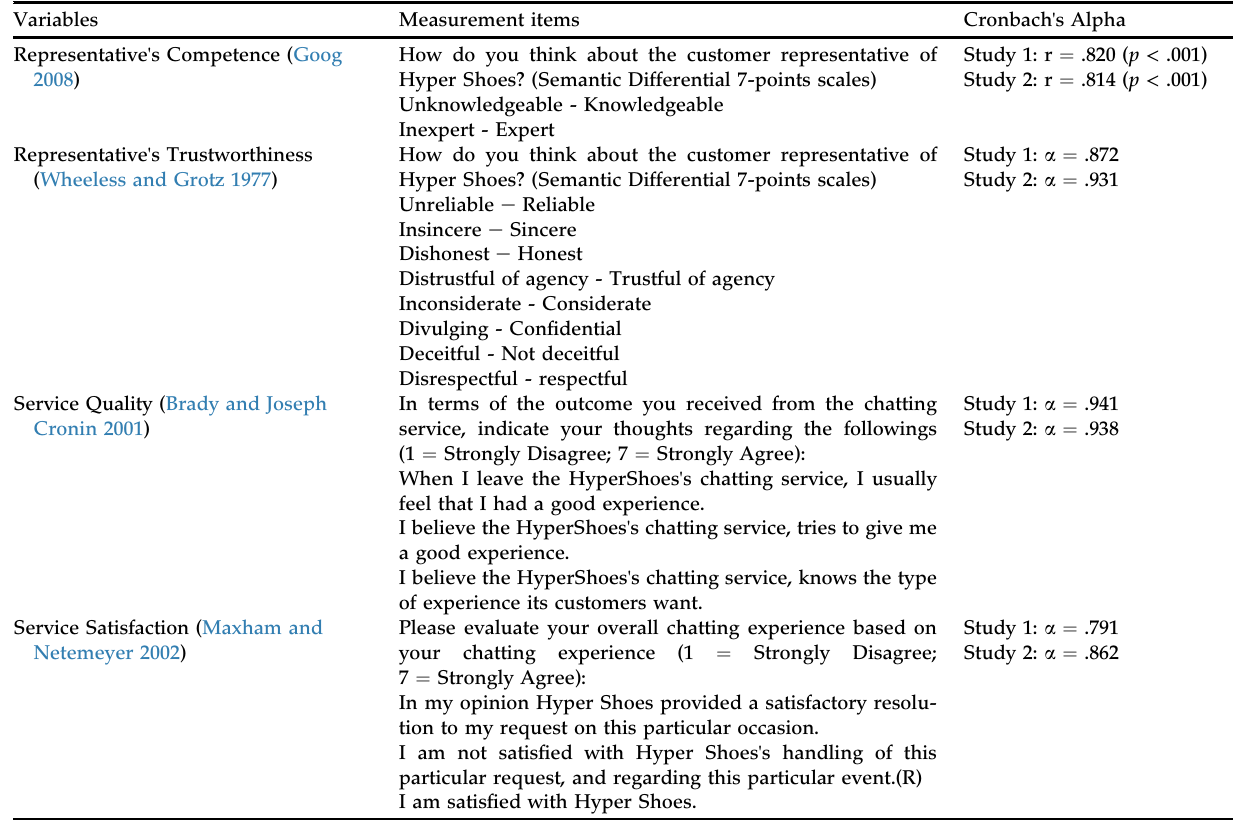
Table 1. Measures used in studies 1 and